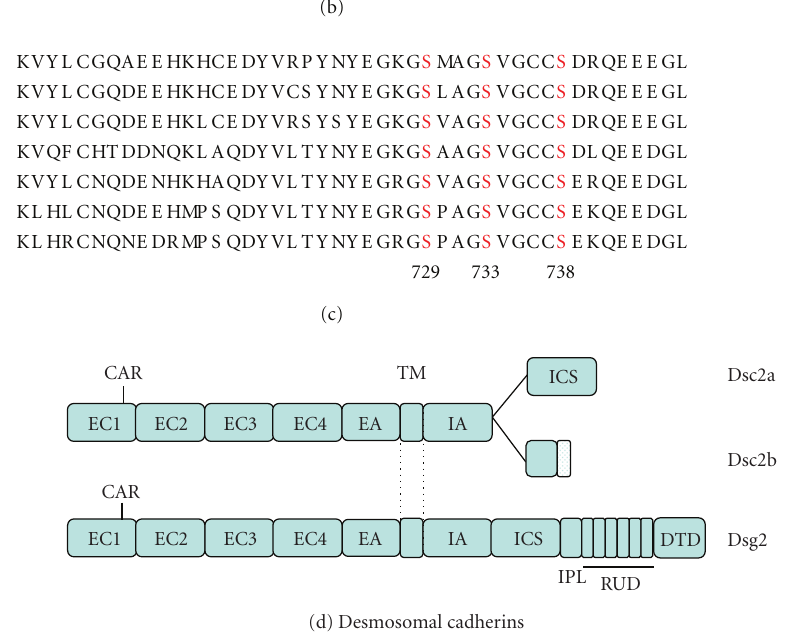
Figure 6: Mutations of phosphorylation sites in desmoglein and desmocollin produce slight increases in desmosomal hyperadhesion. (a) and (b) show conserved predicted phosphorylation site (in red) in the cytoplasmic domains of desmogleins and (c) shows similar sites in desmocollins. These were mutated to alanine and the mutant proteins expressed in MDCK cells. The e ff ects on desmosomal adhesiveness are described in the text. (d) shows stick models of the desmosomal cadherins desmocollin 2 (Dsc2) and desmoglein 2 (Dsg2). Sites S810 and S814 are located towards the C-terminal end of the ICS (intracellular cadherin-specific) region of Dsg2, S866 towards the C-terminal end of the IPL (intracellular proline-rich) region, and S1051 in the sixth repeat of the specific repeat unit domain (RUD). Sites S729, S733, and S738 are towards the C-terminal end of the ICS region of Dsc2a but are absent from the shorter C-terminal region of Dsc2b because alternative splicing truncates this region. (d) is reproduced from the study by Garrod and Chidgey in [1].